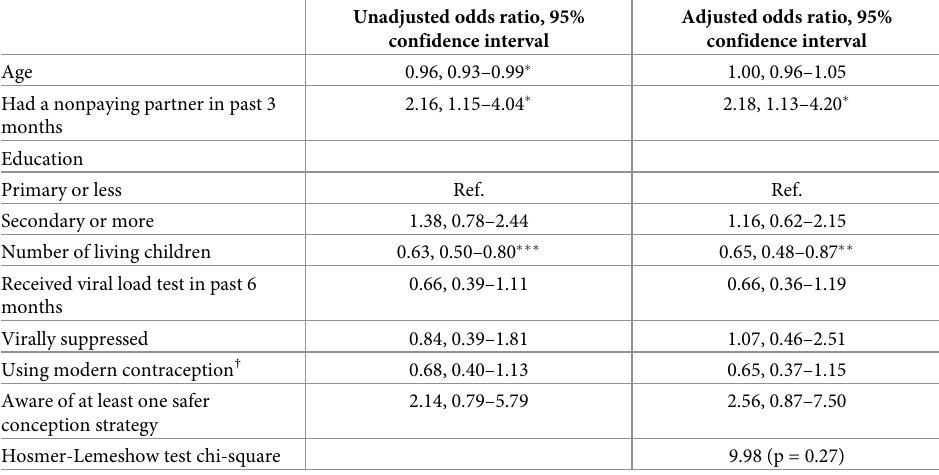
Table 2. Correlates of wanting a child within two years (N =